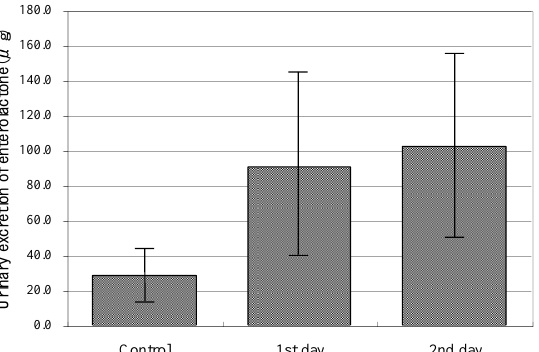
Figure 10. Urine excretion of enterolactone ( µ g) in male SD rats following the oral administration of phillyrin (25 mg/kg) (data from Prof. H. Adlercreutz).